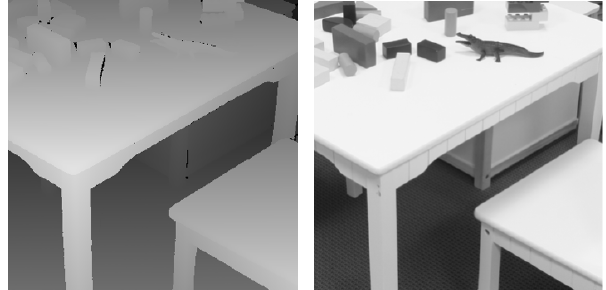
Figure 2. Observation of the similarities of discontinuity regions between a depth image and the corresponding scene